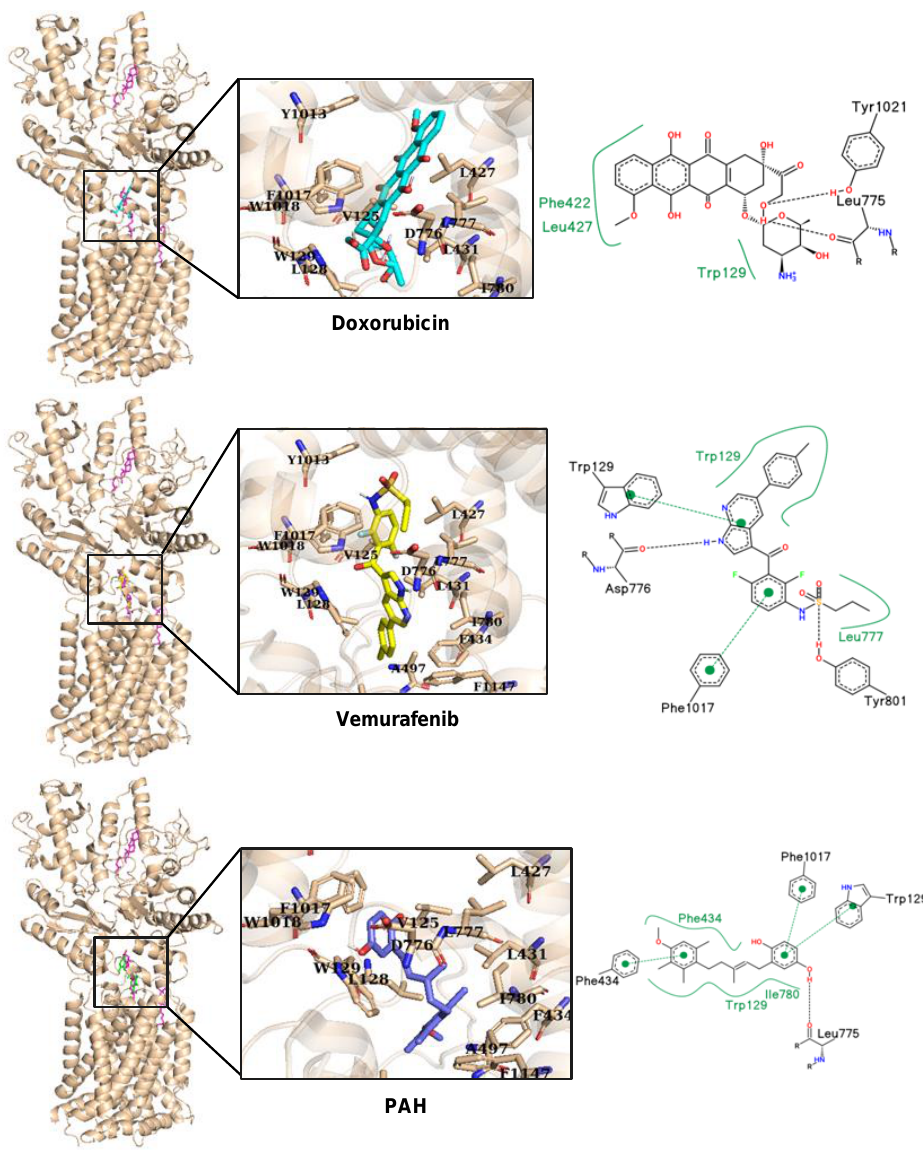
Figure 7. Docking of doxorubicin, vemurafenib, and PAH in the human Ptch1 protein. Chain A of pdb 6n7h with cholesterol (magenta) and molecules: doxorubicin (cyan, top), vemurafenib (yellow, middle), and PAH (blue, bottom) binding in the same binding cavity when docked using Vina. All ligands interact with similar amino acids (see Table 3). Binding interactions between docked molecules and Ptch1 amino acids are represented in black dash for H-bonds and green for hydrophobic interaction/pi-stacking.